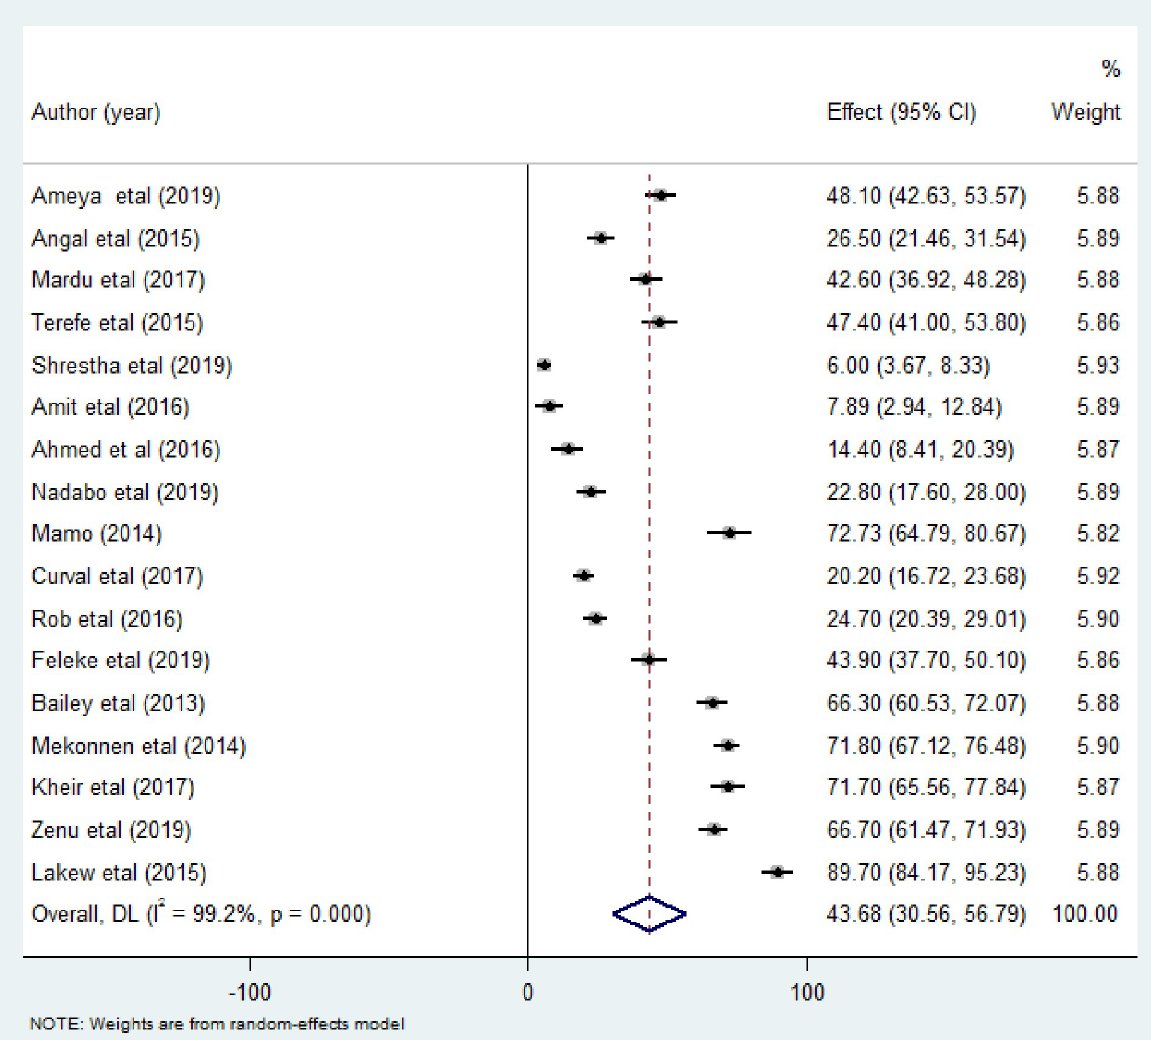
Fig 2. Forest plot showing the pooled prevalence estimate of intestinal parasitic infection among street dwellers and prison